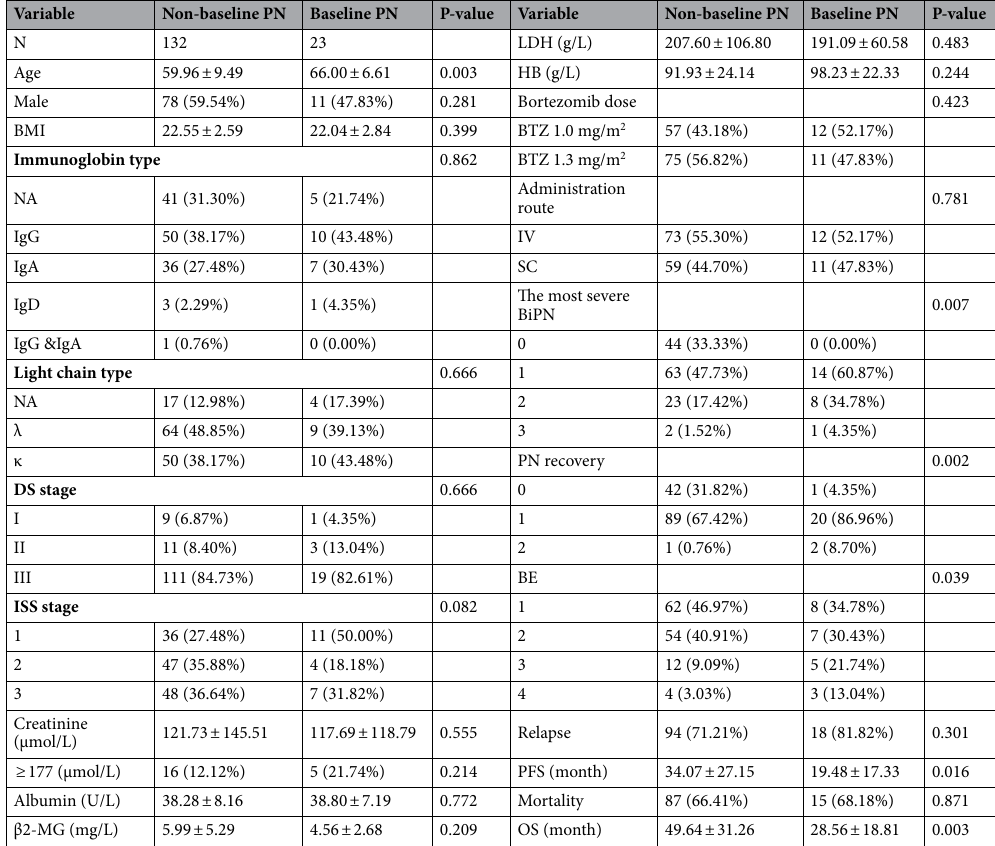
Table 1. Description of clinical data. The best curative effectiveness ≤ complete remission (CR) was labelled as 1, very good partial remission (VGPR) as 2, partial remission (PR) as 3, stable disease (SD) as 4. BMI body inductive therapy, BE the best efficacy during the inductive, PFS Progression-free survival, OS overall